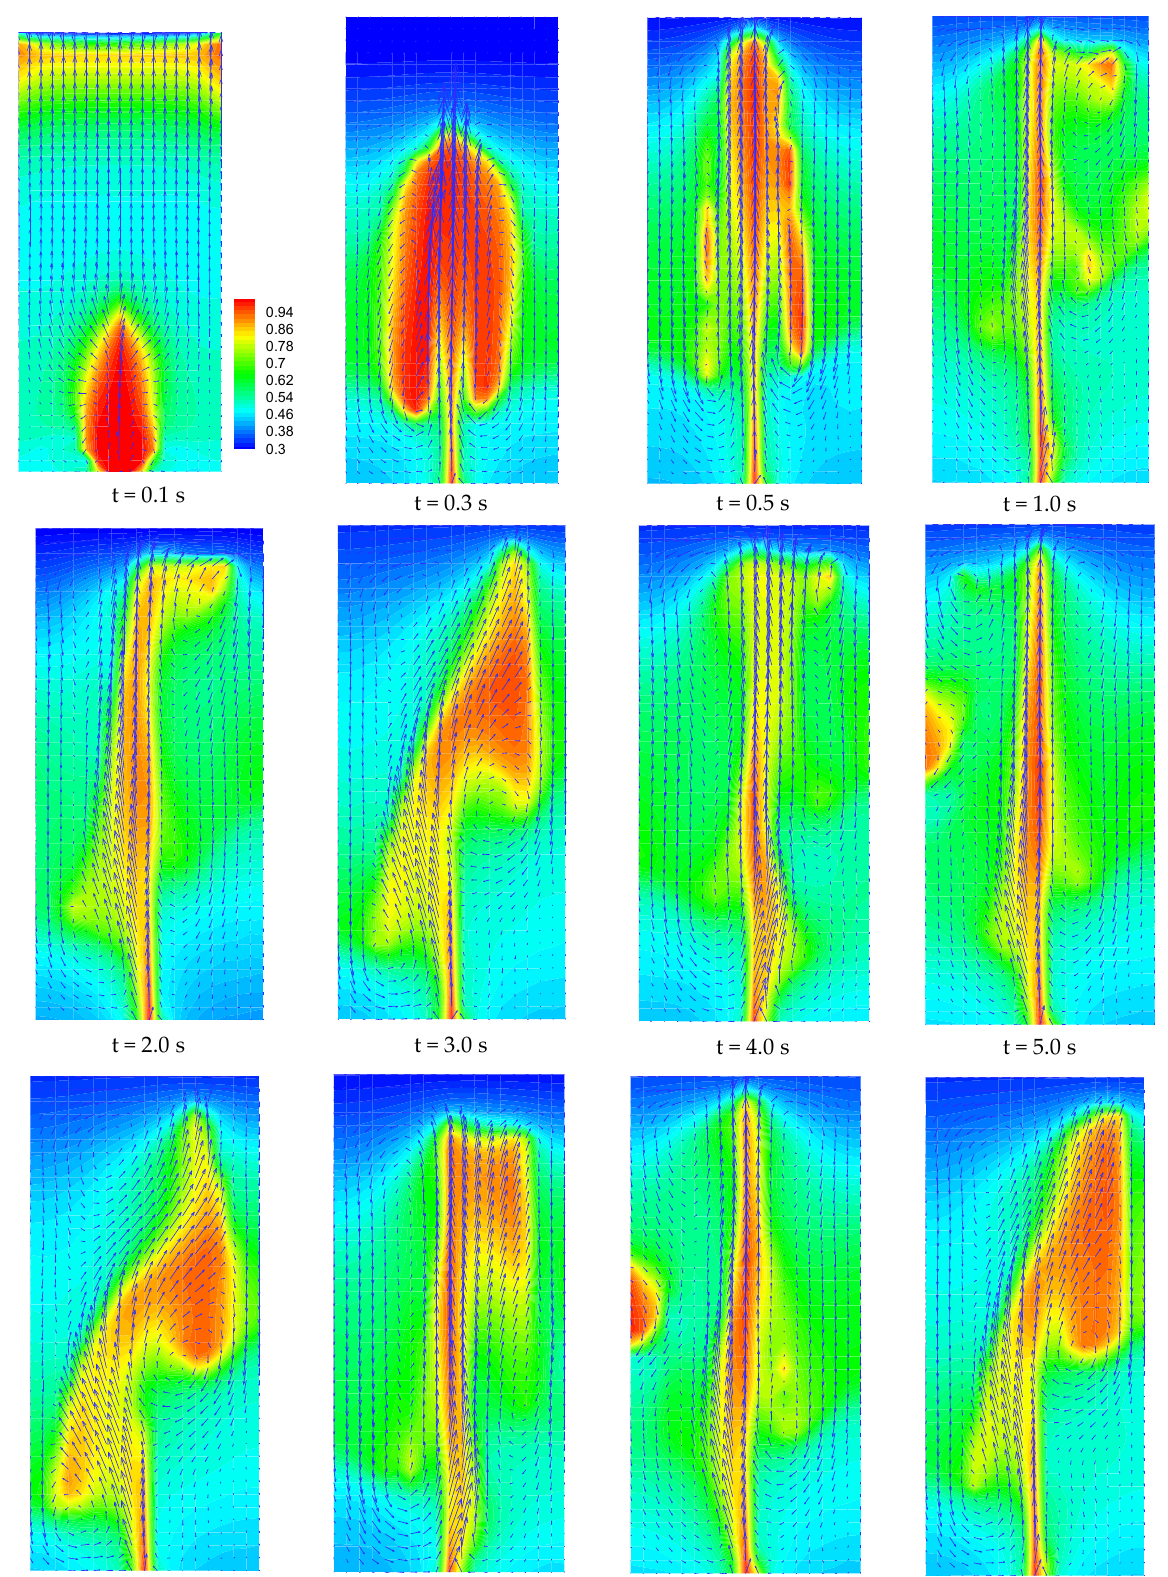
Figure 4. Instantaneous porosities and velocities of EG particles in a bubbling fluidized bed, ρ p = 800 kg/m 3 .